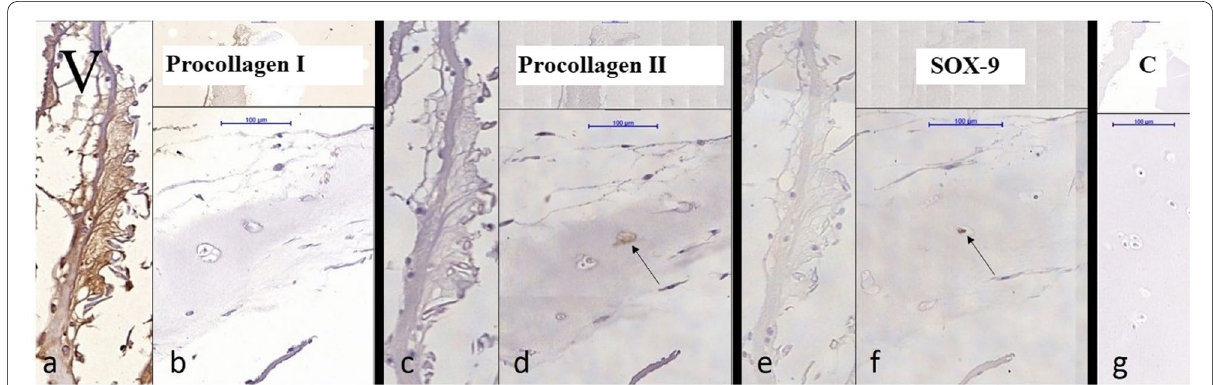
Fig. 5 Cartilage cultivation containing cartilage pieces treated with 100 U/ml collagenase and cultured with fibrin matrix (Well 16). a and b : Fibrin respectively cartilage. Figure a representing immunohistochemistry with antibody against procollagen type I that was non‑specific and b representing positive staining within cartilage. c and d : Fibrin respectively cartilage. Negative respectively positive immunohistochemistry with antibody against procollagen type II. e and f : Fibrin respectively cartilage. Negative respectively positive immunochemistry with antibody